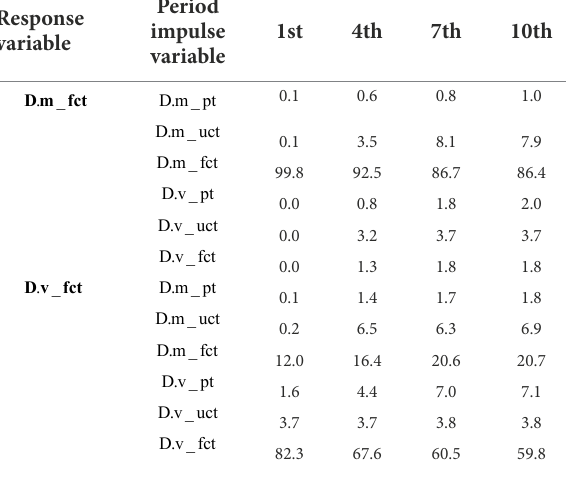
TABLE 7 The source of contribution ( . _ Dm fct or . _ Dv fct as response variable). Response